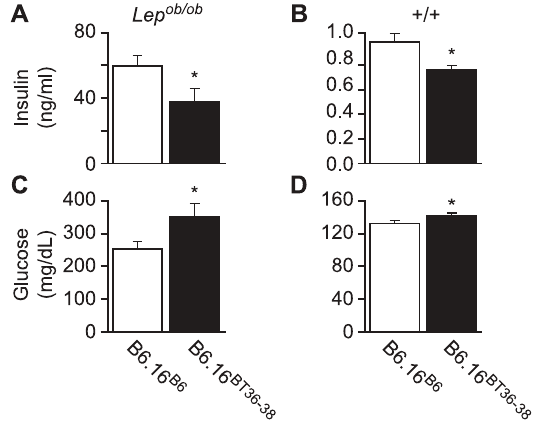
Figure 4. Plasma insulin and glucose levels in the B6.16 BT36–38 male mice. Random-fed plasma insulin (A and B) and glucose (C and D) were measured in 10-week Lep ob/ob and lean B6.16 B6 and B6.16 BT36–38 male mice. Values are means 6 S.E. of N $ 10. * p # 0.05 for plasma glucose and insulin levels in B6.16 BT36–38 mice vs. control B6.16 B6 mice.